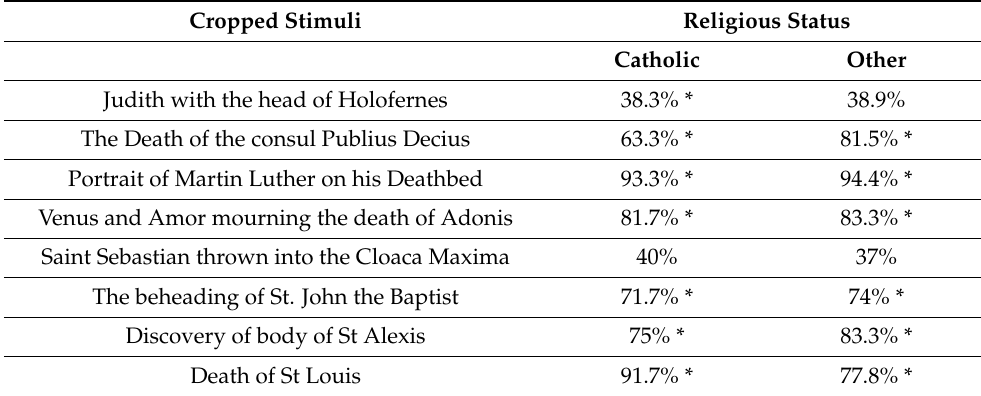
Table 2. Summary of contingency tables indicating the correct recognition (%) for religious status. * Indicates correct recognition above chance level, p <